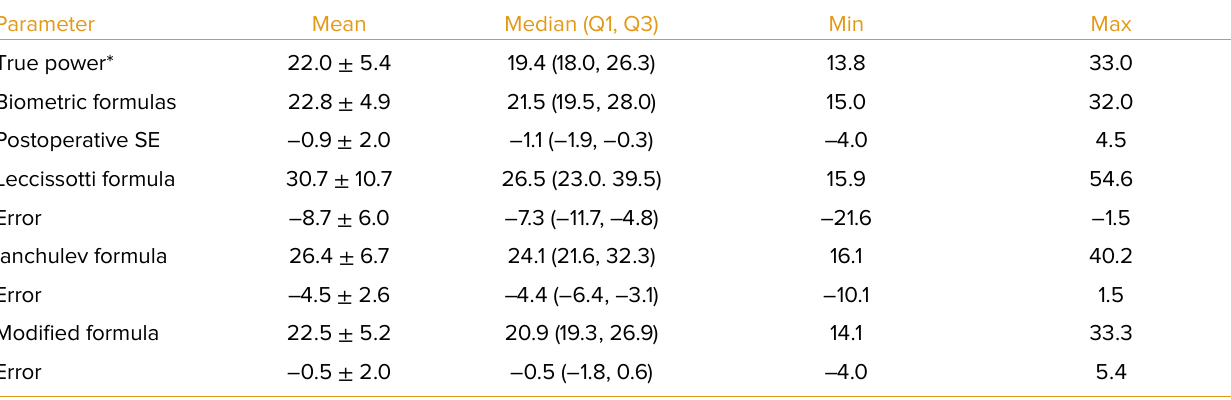
Table 2. Mean and median of calculated IOL power with different formulas.